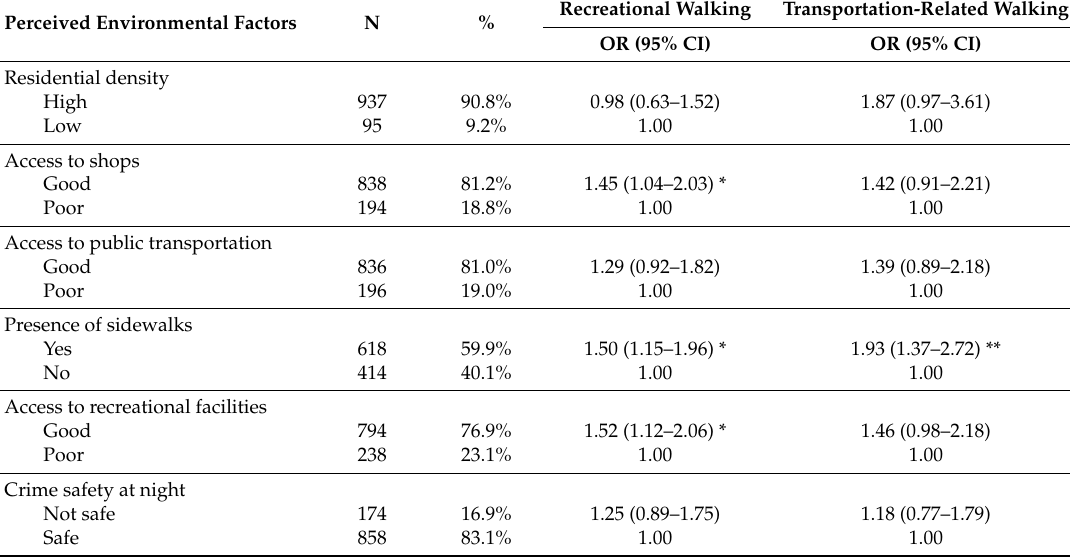
Table 3. Perceived environmental factors associated with walking for recreation and